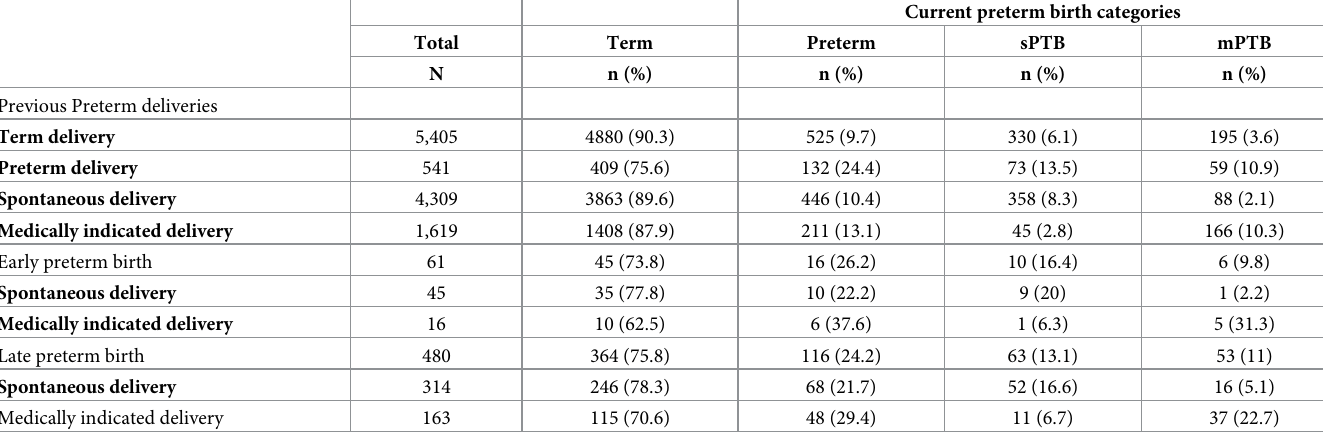
Table 3. Classification of rate of preterm birth recurrence by clinical subtypes and gestational age categories (N =